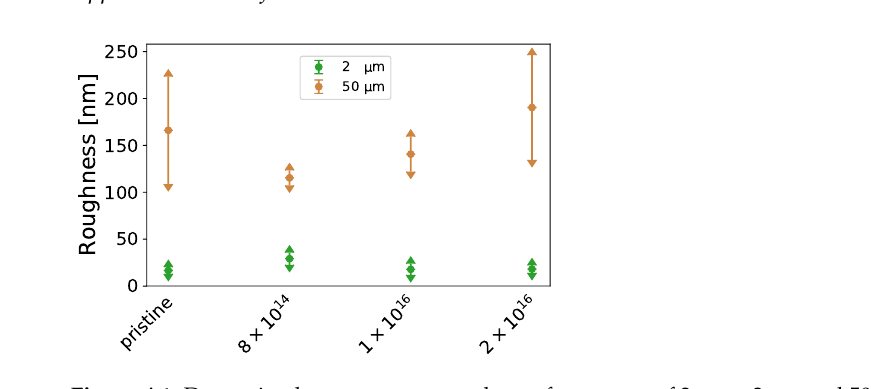
Figure A1. Determined mean square roughness for an area of 2µm × 2µm and 50µm × 50µm of the investigated TNSs.